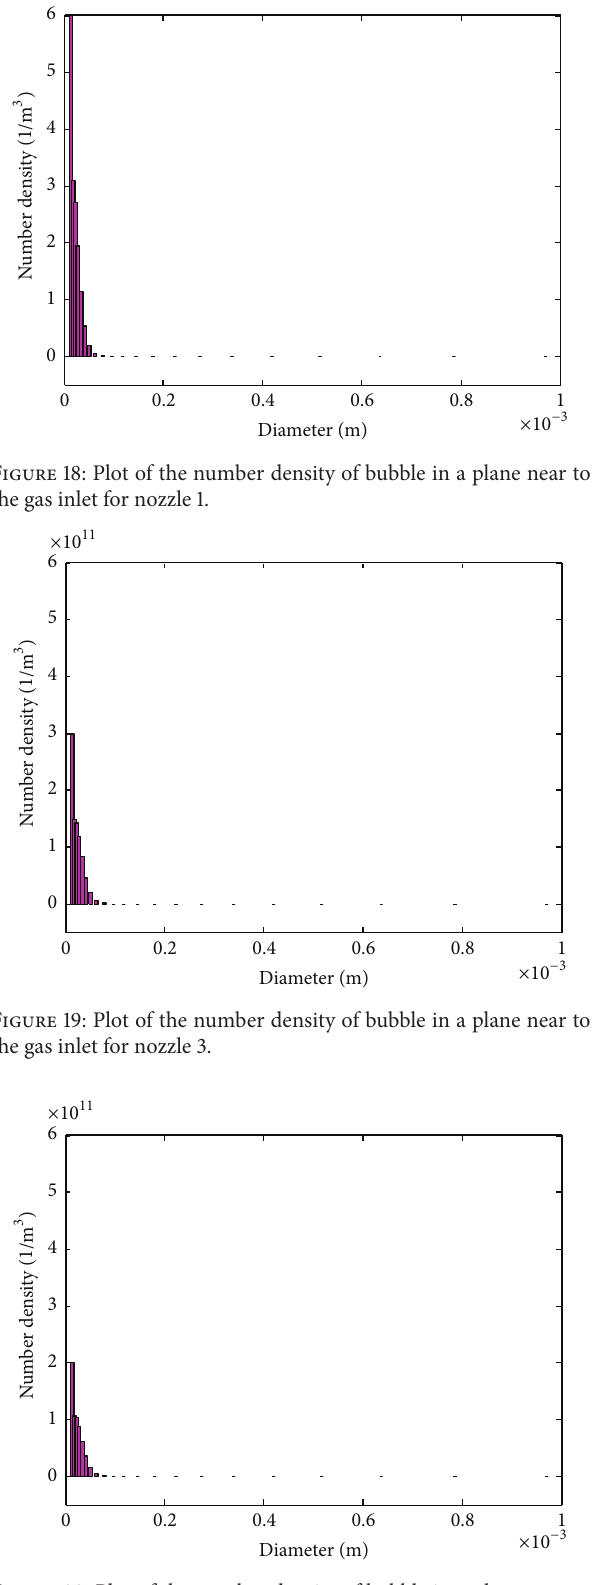
Figure 20: Plot of the number density of bubble in a plane near to the gas inlet for nozzle